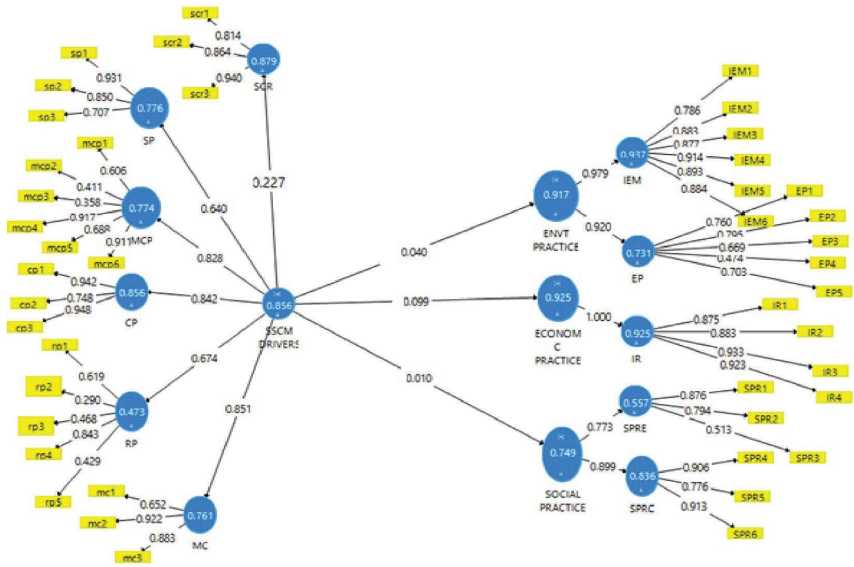
Figure 4: Generated hierarchical structural model.